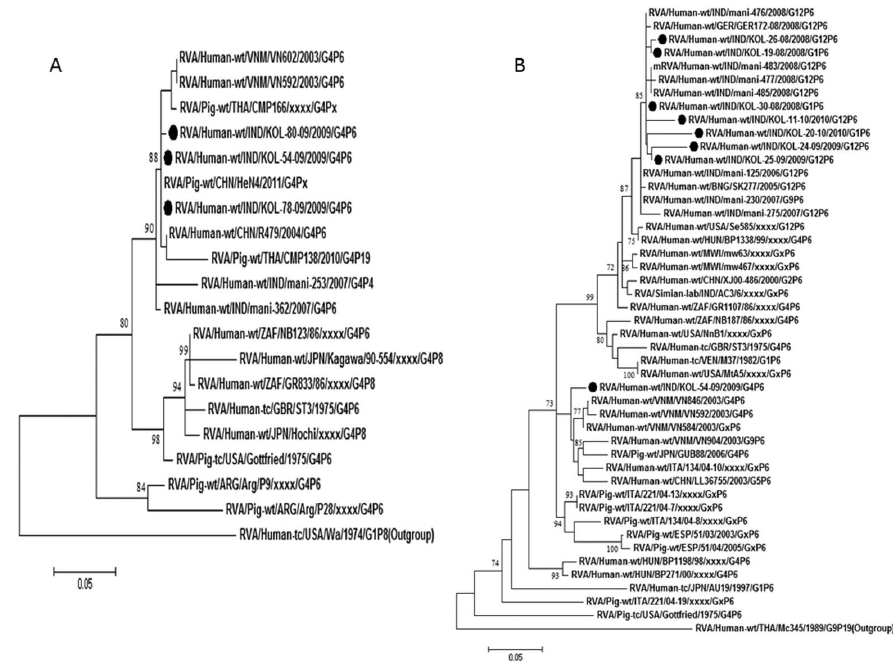
Figure 5. A and B. Phylogenetic trees of the G4 and P [6] strains of Kolkata. Phylogenetic trees constructed from the nucleotide sequences of VP7 genes of A. G4; and VP4 genes of B. P[6] strains of Kolkata, isolated during January 2008 through December 2010, with other representative G4 and P[6] strains respectively. All G4 strains indicated its genetic relatedness with the porcine or porcine-like human G4 strains. Scale bar, 0.05 substitutions per nucleotide. Bootstrap values less than 70% are not shown.